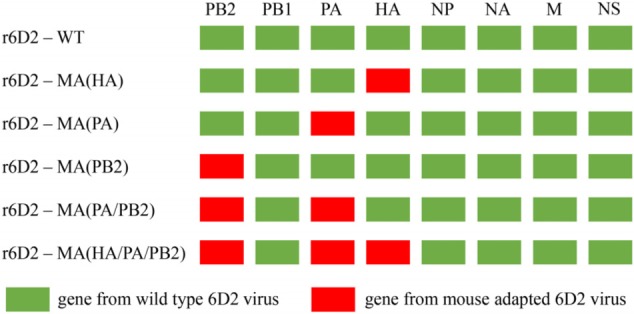
Schematic of reassortant viruses with different plasmid combinations.